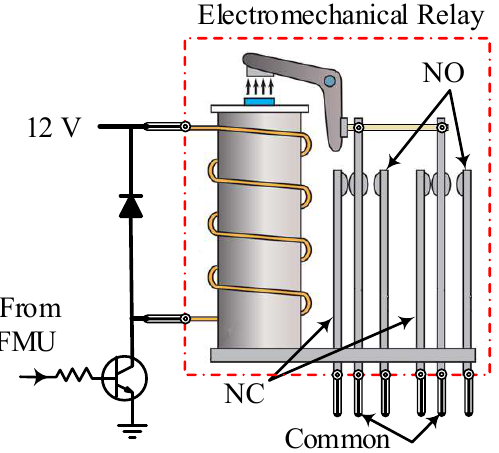
Figure 8. Electromechanical relay.